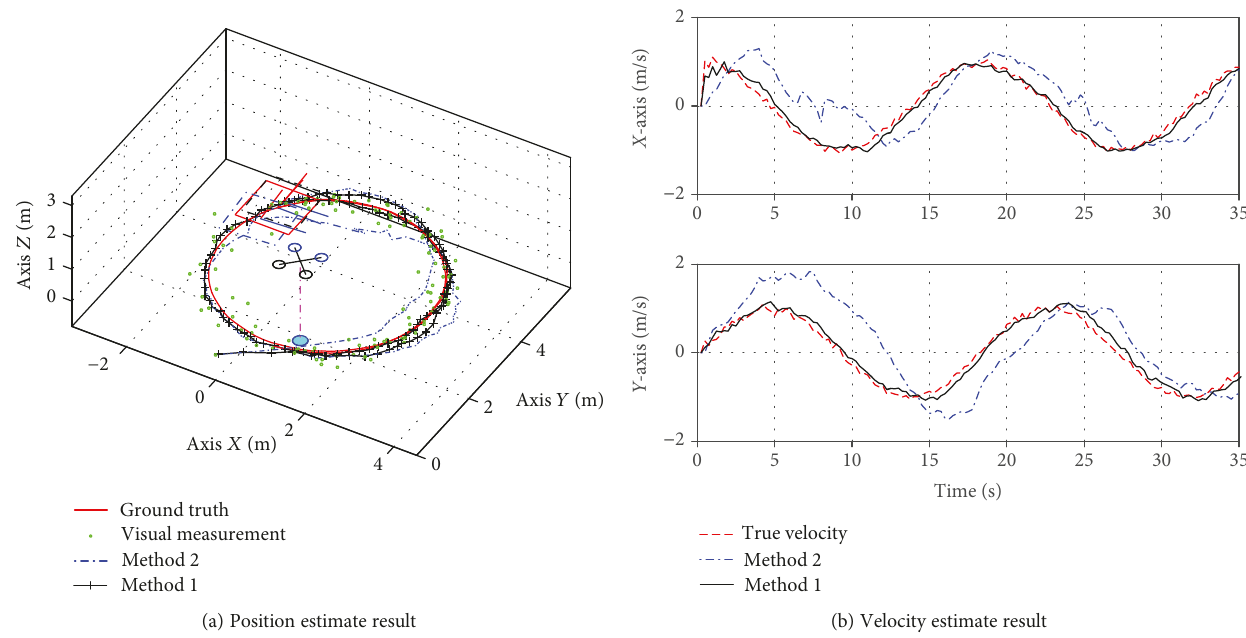
Figure 6: Estimate results of the moving